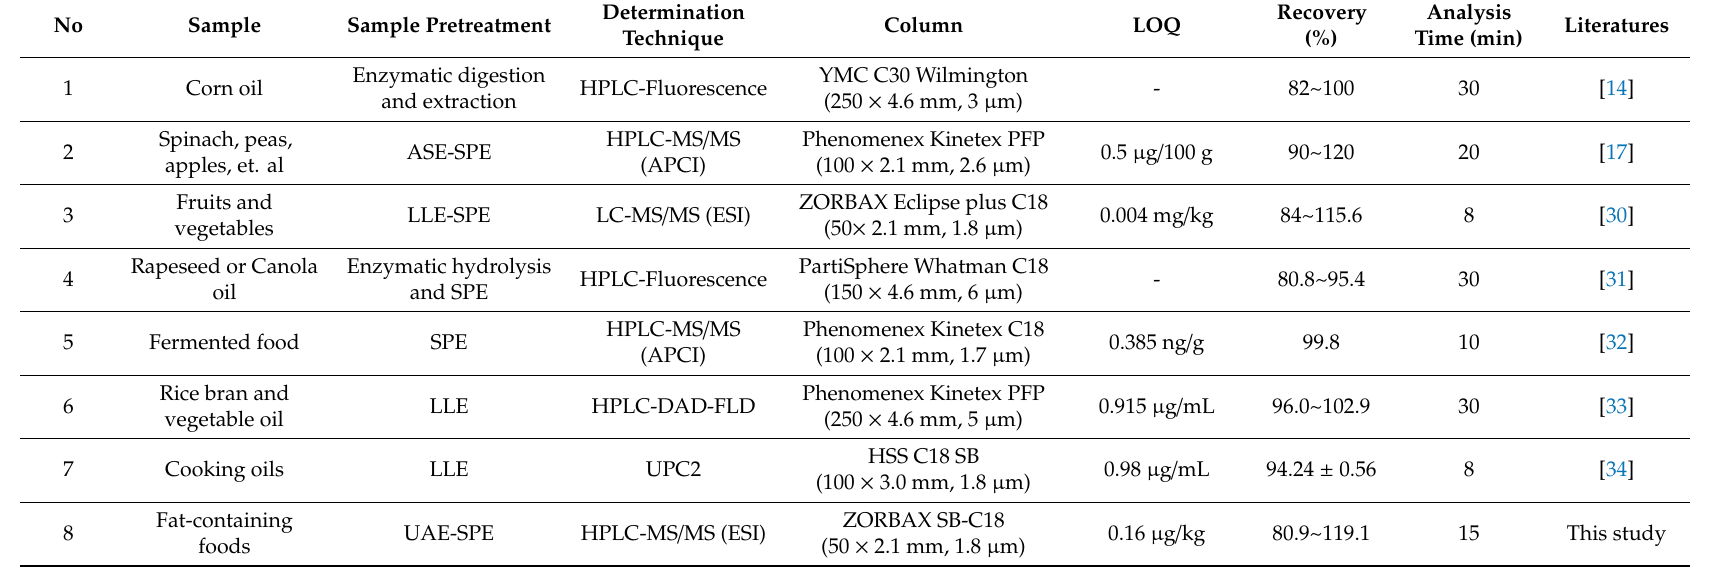
Table 3. Comparison of the method proposed in this study with the previous